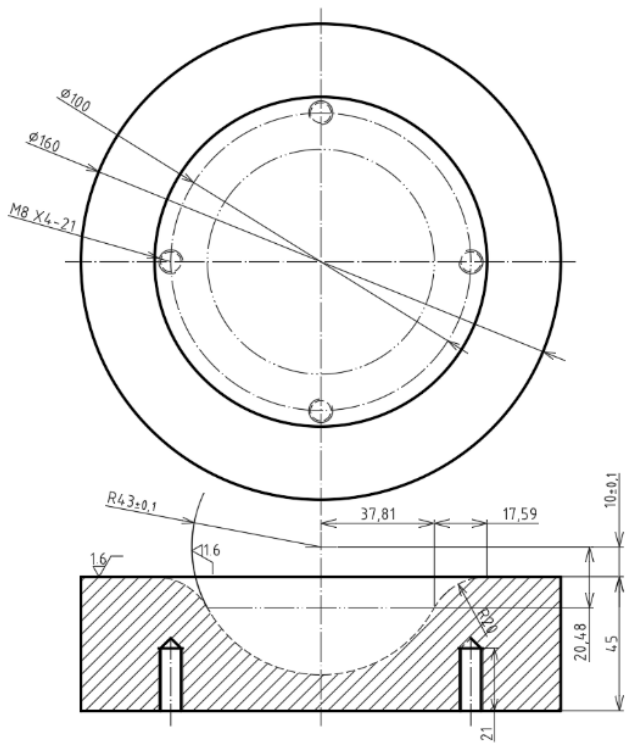
Figure 2. The detailed dimension of the die (unit: mm) .